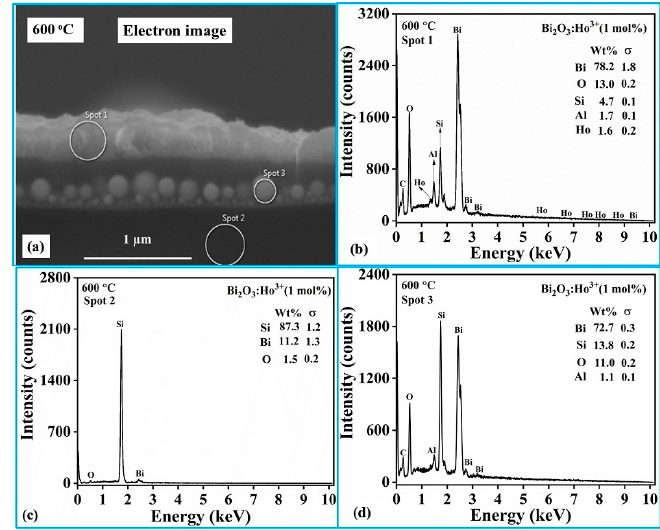
Figure 7. SEM cross-section. ( a ) EDS taken at spot 1 ( b ), spot 2 ( c ) and spot 3 ( d ) of Bi 2 O 3 :Ho 3 + (1 mol.%) deposited at T S = 600 ◦ C.